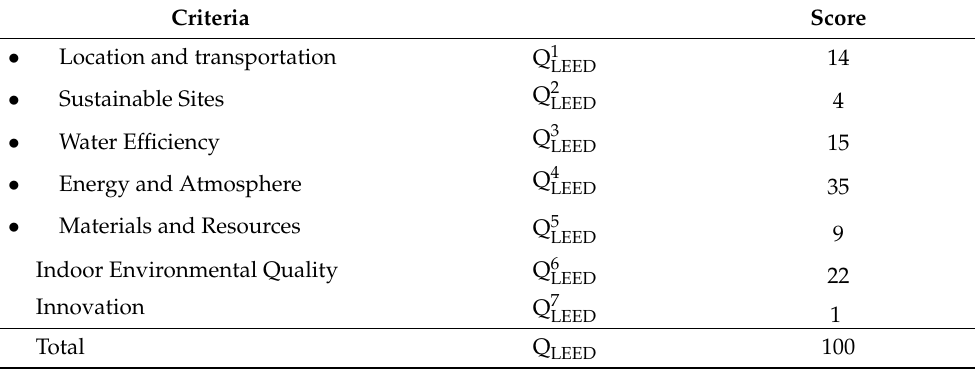
Table 2. Criteria of LEED v4.1 O + M. Criteria